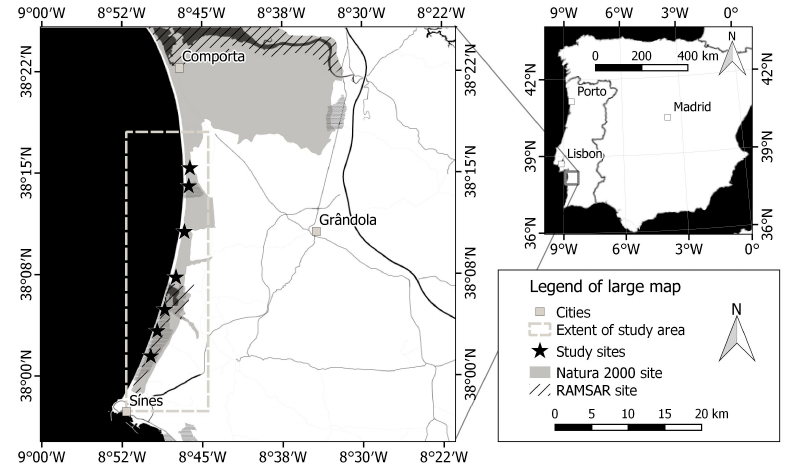
Figure 1. Study area and study sites in the stabilized coastal dunes of the Natura 2000 site “Comporta/Galé” in SW Portugal. “Comporta/Galé” in SW